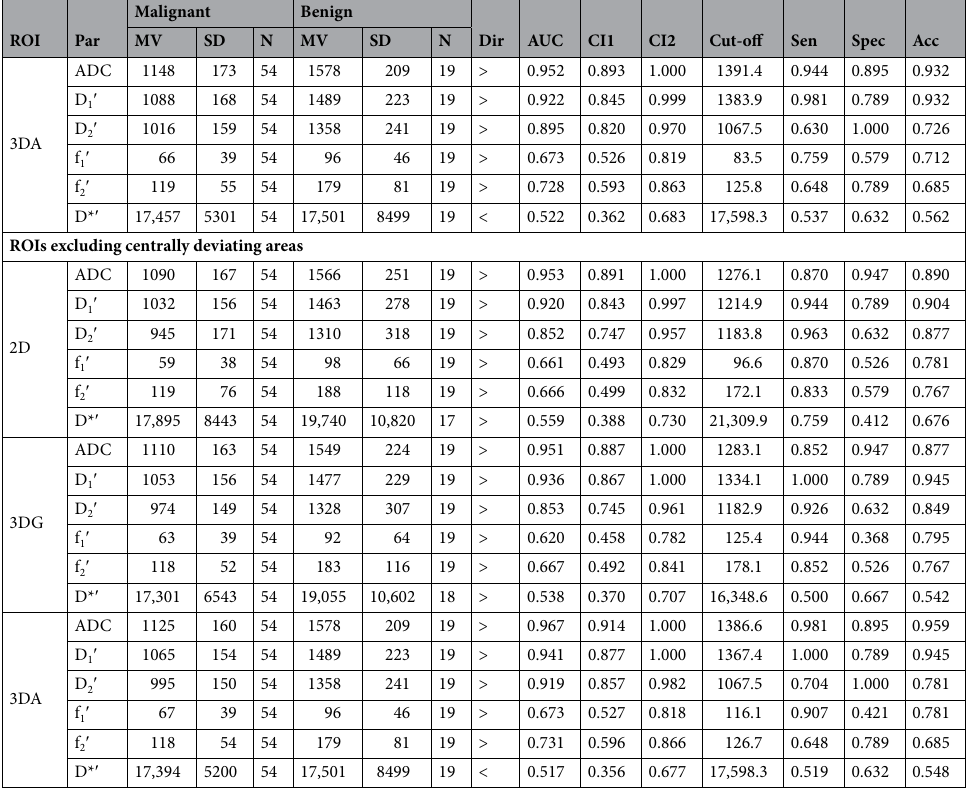
Table 3. Results of ADC and IVIM parameter value analysis within different regions of interest (ROIs) and receiver operating characteristic (ROC) analysis of benign and malignant liver lesions. ADC, D 1 ’, D 2 ’, D*’ values are given in units of 10 −6 mm 2 /s, f 1 ′ and f 2 ’ values are given in units of 10 −3